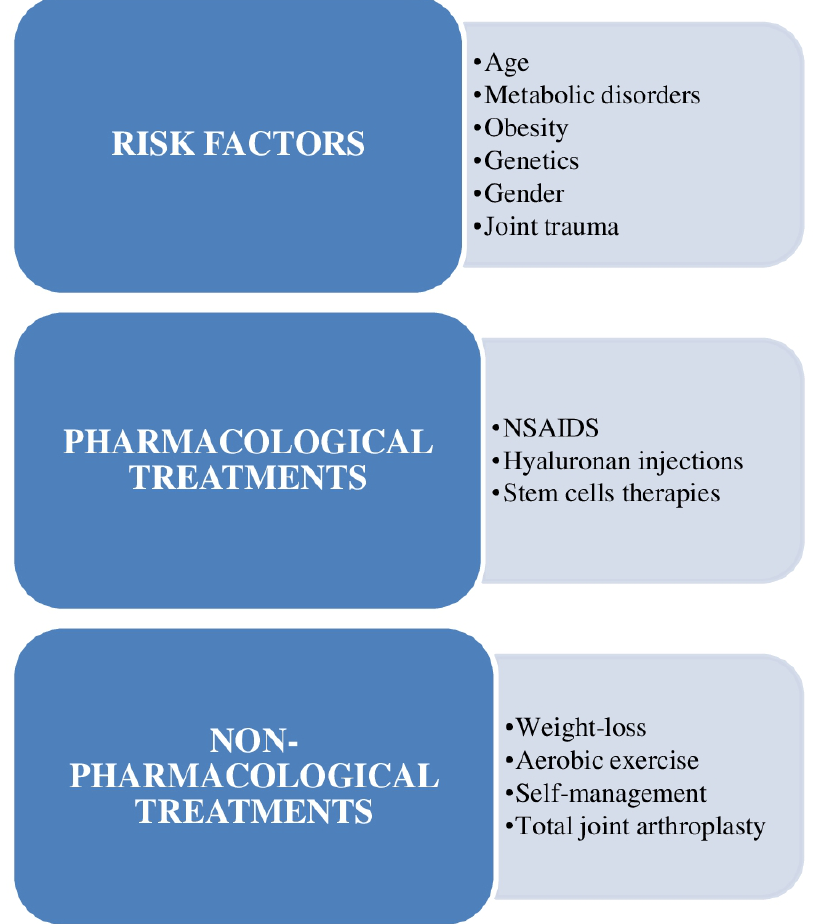
Figure 1. Outline of the risk circumstances for the appearance of osteoarthritis (OA) and the contemporary pharmacological and nonpharmacological approaches for its management, emphasizing the scarcity of efficacious methods and the chance for invention in this field. NSAIDS = nonsteroidal anti-inflammatory drugs.